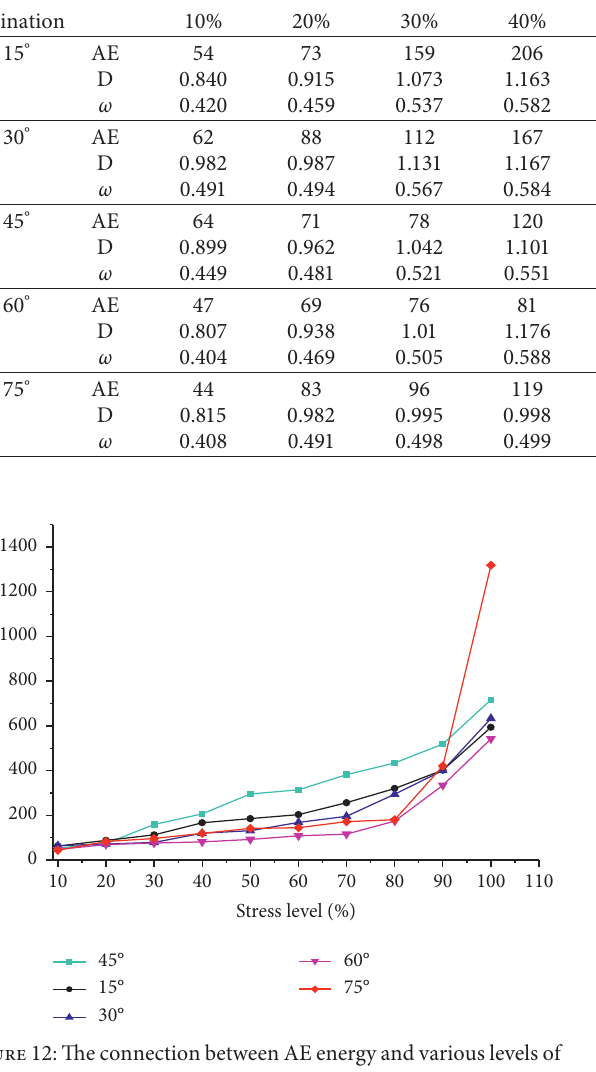
Figure 11: Fractal dimension of damage area calculation results when α � 45 ° (stress level of 70% ). Table 3: AE energy and fractal dimension values for numerical samples at various stress levels Stress level